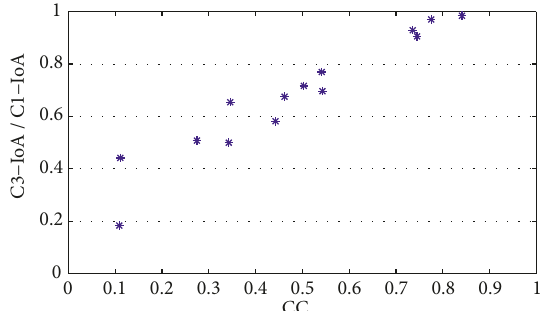
Figure 12: Comparison of the precision of the adaptive models calculated according to Cases 1 and